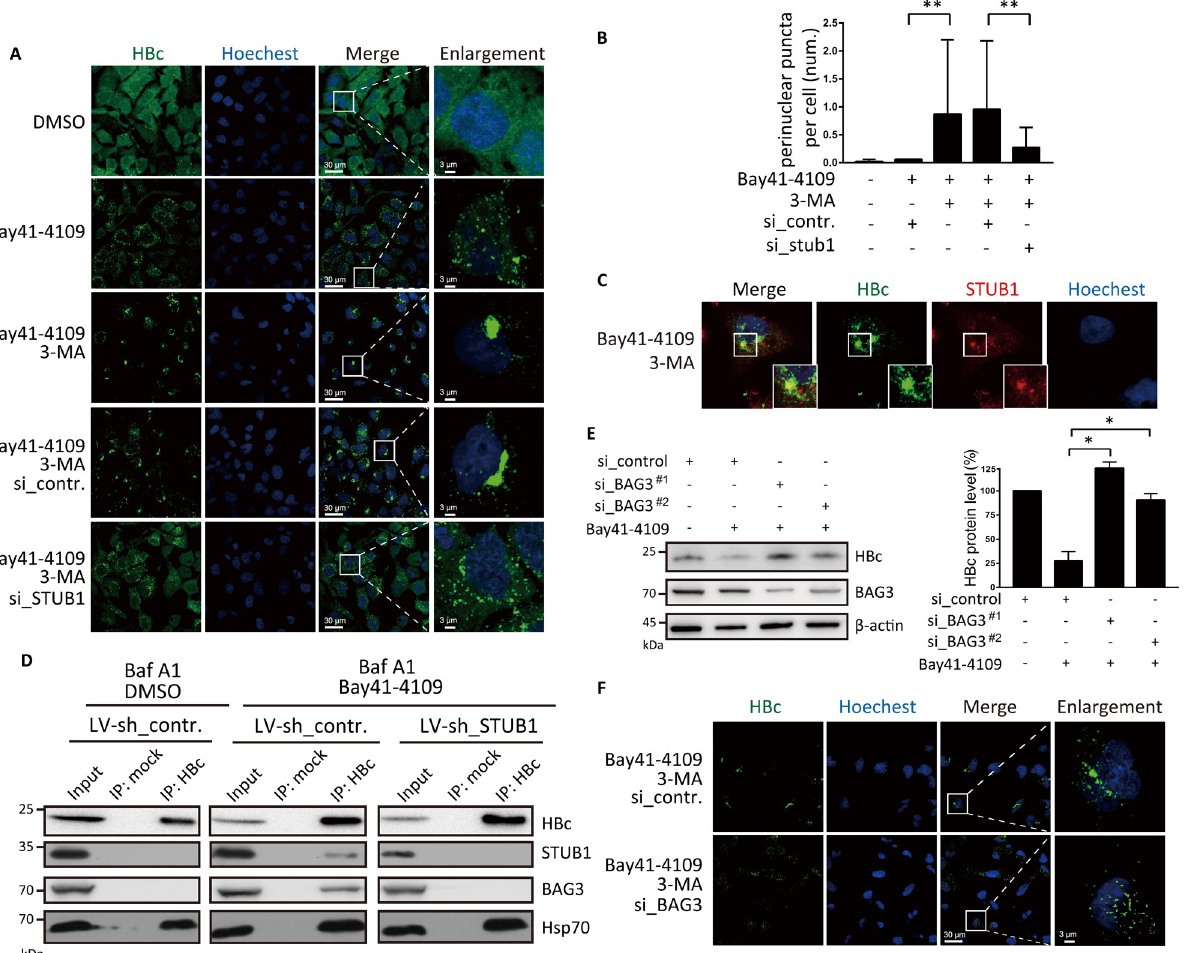
Fig 5. STUB1 mediates transport of Bay41-4109-induced aberrant non-capsid polymers to the perinuclear region. (A) HepAD38 cells were treated with 1 μ M Bay41-4109 alone, Bay41-4109 and 10 mM 3-MA, or DMSO for 2 d. For STUB1 silencing, cells were transfected with si_STUB1 or si_control at 36 h before treatment with both Bay41-4109 and 10 mM 3-MA. Cells were immunostained for HBc (green) as indicated. Nuclei were stained with Hochest33342. The “enlargement” column shows enlarged images of the areas indicated by white boxes in the “merge” column. Scale bars are 30 μ m in the “merge” column and 3 μ m in the “enlargement” column. (B) Numbers of perinuclear HBc puncta (diameter exceeds 3 μ M in any direction) per cell. 100 cells were counted. The error bars indicate ± SD. �� p < 0.01, p value was calculated by unpaired two-tailed student’s t-test. (C) HepAD38 cells were treated with 1 μ M Bay41-4109 and 10 mM 3-MA for 2 d. Cells were immunostained for HBc (green) and STUB1 (red) as indicated. Nuclei were stained with Hochest33342. Areas indicated by white boxes are enlarged. Arrows point to typical co-localized sites. Scale bar is 10 μ m. (D) HepAD38 cells transduced with LV-sh_STUB1 or LV-sh_control were treated with 1 μ M Bay41 or DMSO for 24 h, and all the cells were treated with 0.1 mM BafA1 for 12 h. Cell lysates were immunoprecipitated with HBc antibodies or mock antibodies. Proteins were detected by western blot using antibodies recognizing the respective proteins. (E) HepAD38 cells were transfected with two different siRNAs targeting BAG3 or mock siRNA. At 36 hours after transfection, cells were incubated in medium with 1 μ M Bay41-4109 or DMSO for 2 d. Cell extracts were then analyzed by western blotting using the indicated antibodies (left panel). The quantification results of three independent immunoblots are shown as relative percentages (HBc/Actin) with mock transfection/transduction samples set to 100% (right panel). (F) HepAD38 cells were transfected with si_BAG3 or si_control. 36 h after transfection, HepAD38 cells were treated with 1 μ M Bay41-4109 and 10 mM 3-MA, or DMSO for 2 d. Cells were immunostained for HBc (green) as indicated. Nuclei were stained with Hochest33342. The “enlargement” column shows enlarged images of the areas indicated by white boxes in the “merge” column. Scale bars are 30 μ m in the “merge” column and 3 μ m in the “enlargement”